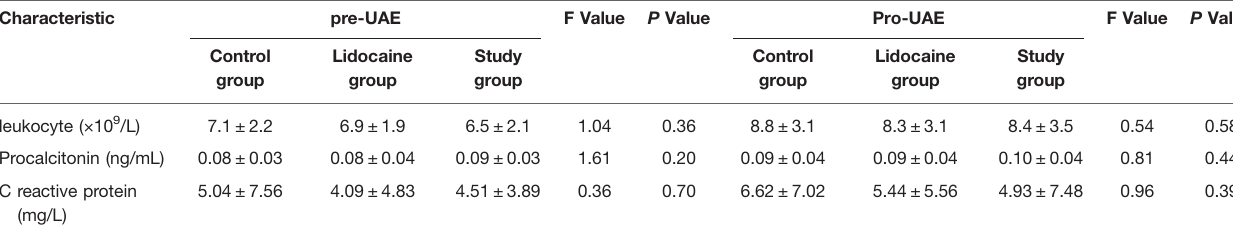
TABLE 2 | Comparison of in fl ammatory indexes among three groups before embolization and 24 h after embolization. Characteristic